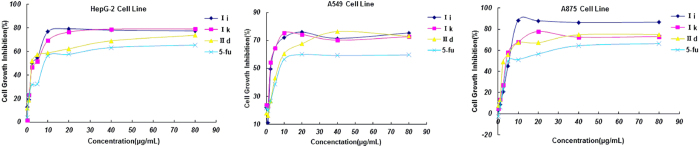
Dose–response analysis of cell growth inhibitory activity for representative compounds Ii, Ik, IId and 5-FU (positive control) against HepG2 (left), A549 (middle) and A875(right) cell lines.